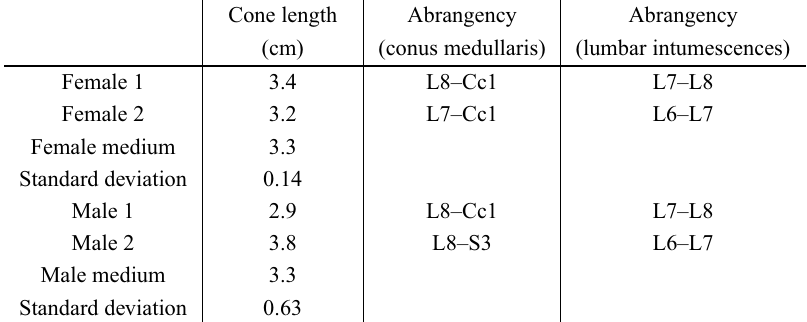
Values of length of the conus medullaris and abrangency of the described